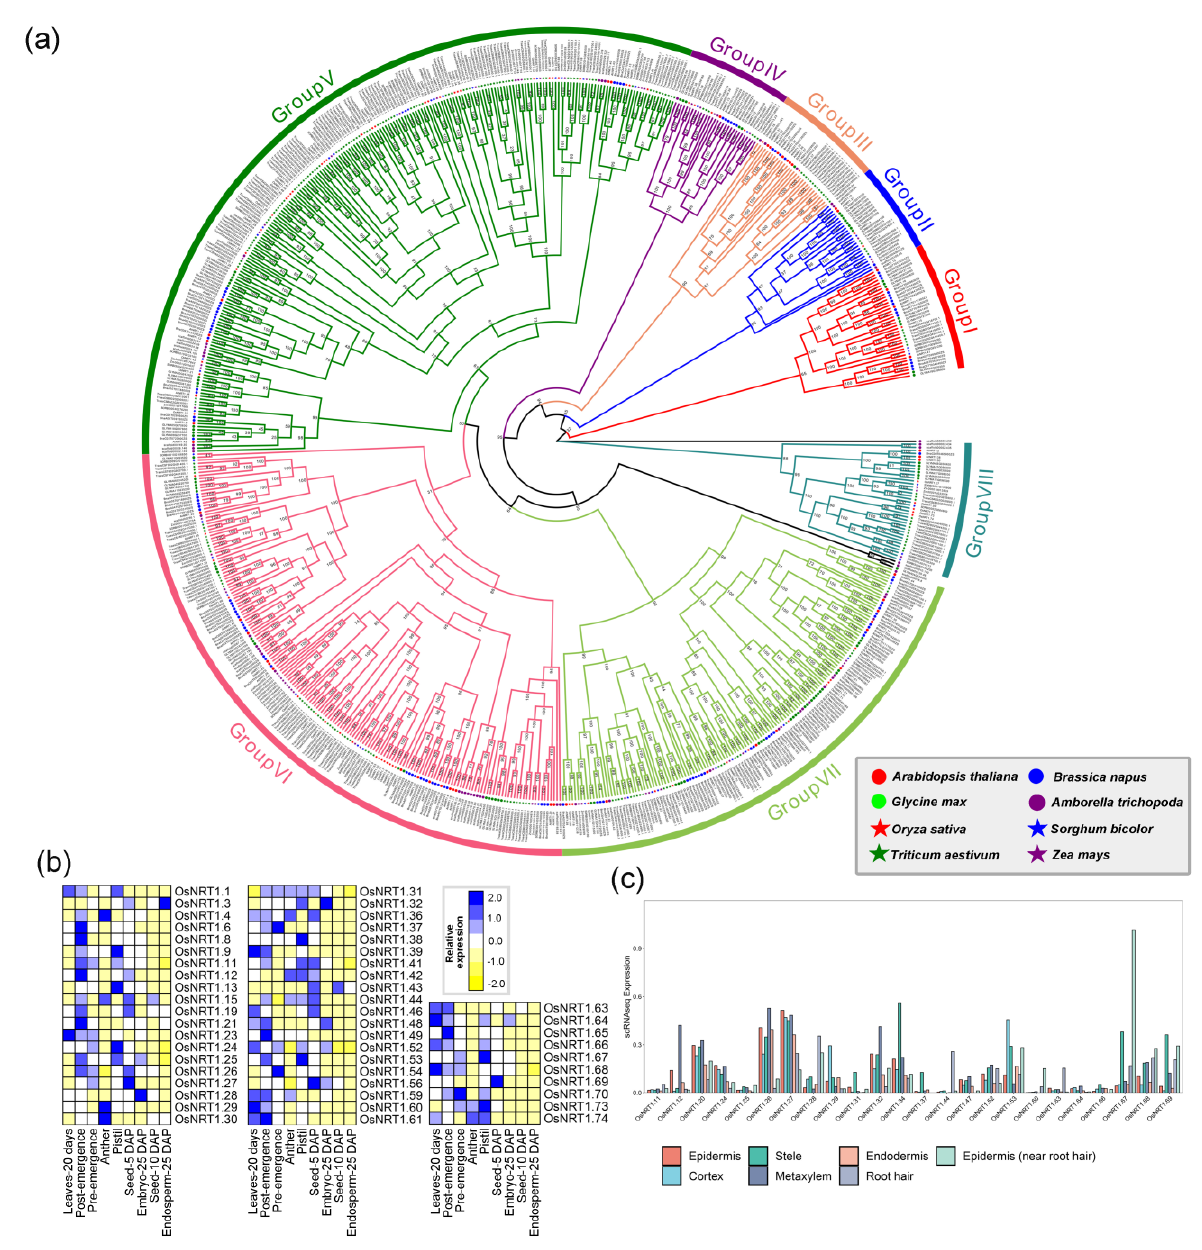
Figure 5. The phylogenetic analysis and expression pattern of the NRT1 superfamily. ( a ) represents the phylogenetic trees of the NRT1 superfamily, splitting into seven groups. The different colors on the branches were defined as the same group. ( b ) indicates the expression heatmap of the NRT1 superfamily, and ( c ) represents the expression of the NRT1 superfamily through the single-cell transcriptome data of roots in rice.